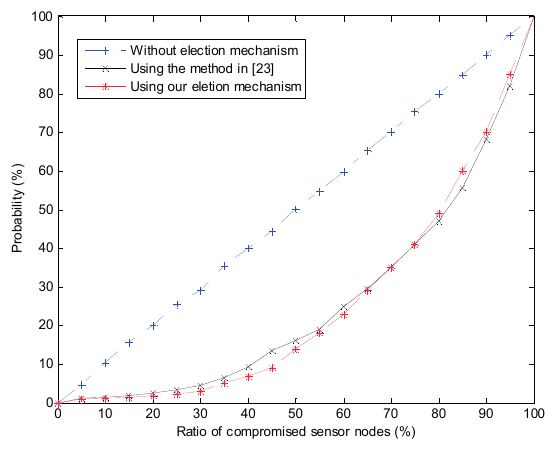
Figure 9. Probability of selecting compromised sensor nodes as cluster